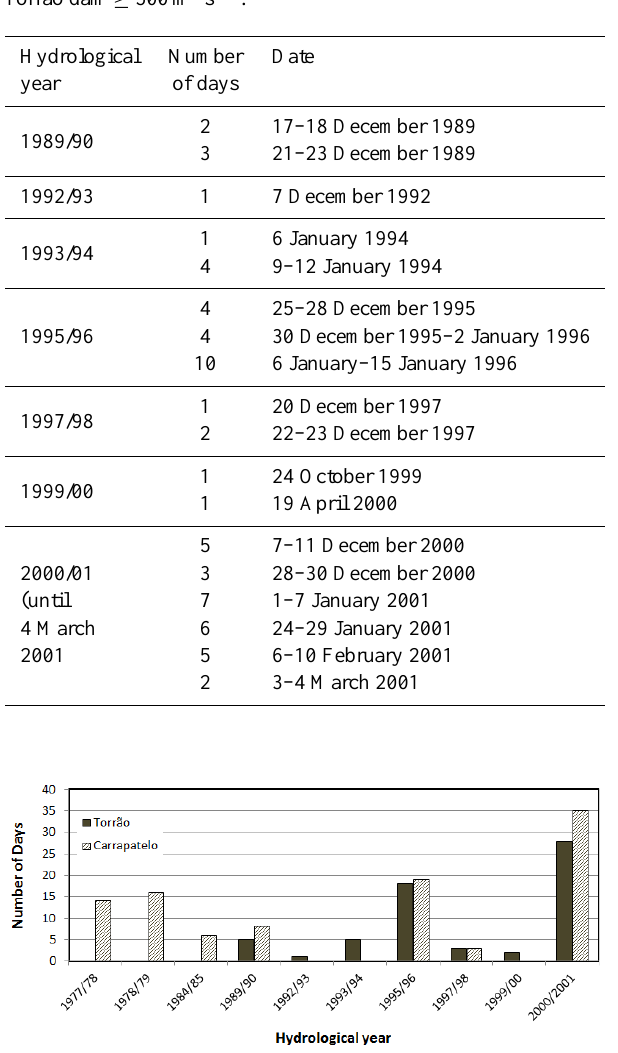
Table 3. Number of days with daily average flow discharged by the Torr˜ao dam ≥ 500m 3 s − 1 .